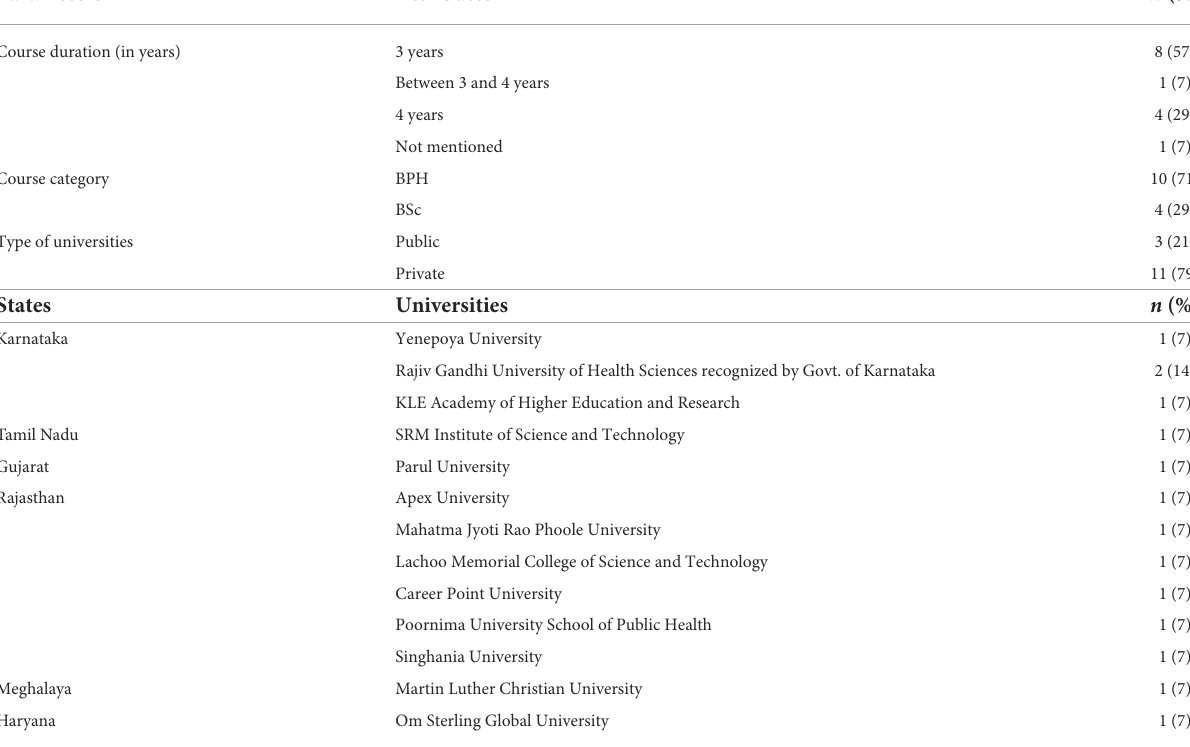
TABLE 5 Frequency of universities providing BPHSc in different states of India ( N = 14). Parameters